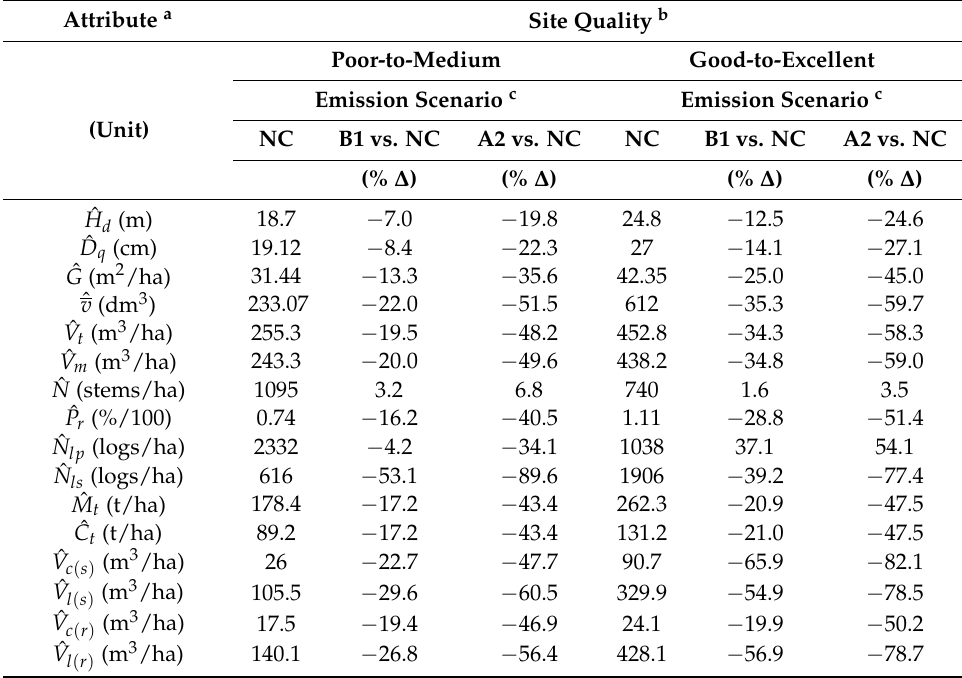
a–c : As defined in Table A1 table notes.